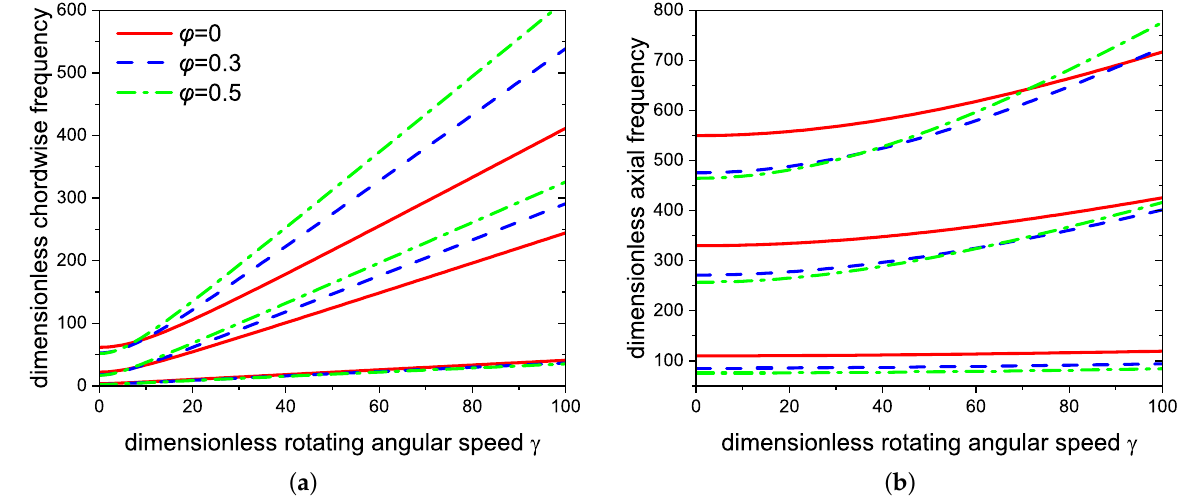
Figure 7. The first three-order dimensionless frequencies of rotating cantilever beams with different free end mass ϕ = 0, 0.3, and 0.5: ( a ) Chordwise frequency; ( b ) Axial frequency.